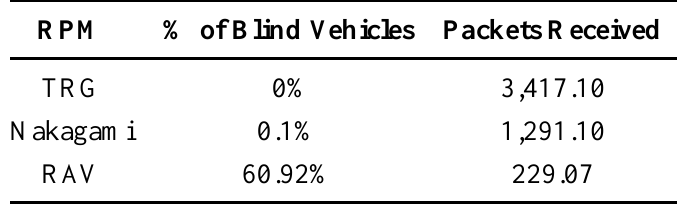
Table 7. Blind vehicles and packets received per vehicle when varying the Radio Propagation